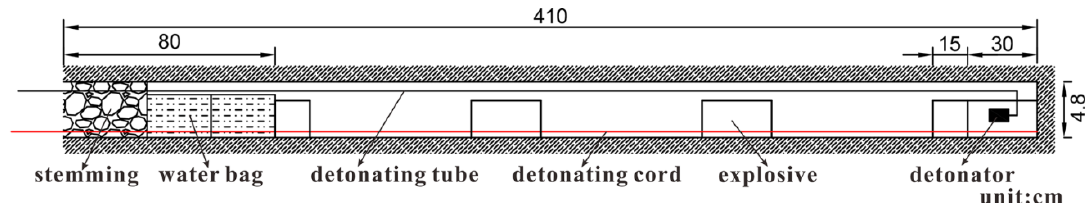
Figure 1. Schematic diagram of a traditional charging structure.